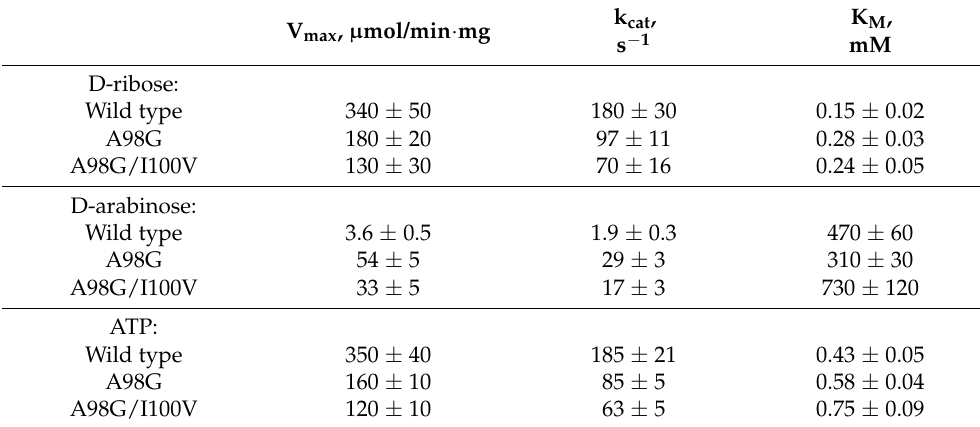
Table 1. Kinetic parameters for the enzymatic activity of wild type EcoRK, A98G and A98G/I100V mutants towards D-ribose, D-arabinose and ATP (determination of activity was performed in three repeats).